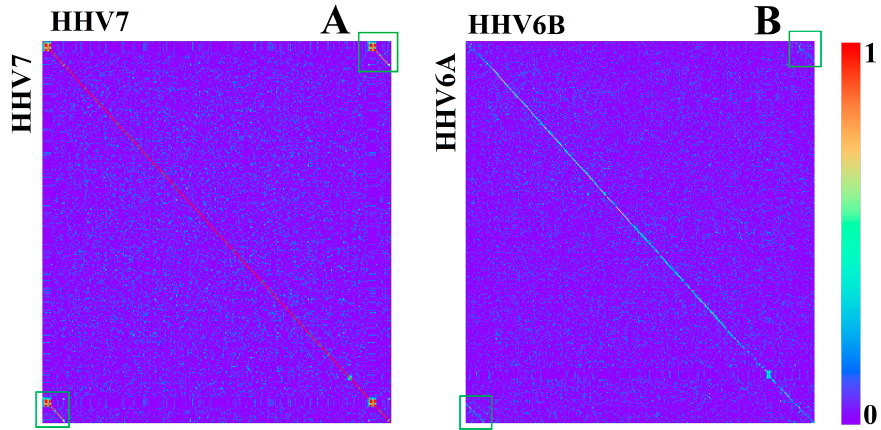
Figure 10. Correlation heatmap between HHV6A with HHV7 ( A ) and HHV6B with HHV7 ( B ) based on k = 1 (bin width 500 bp).